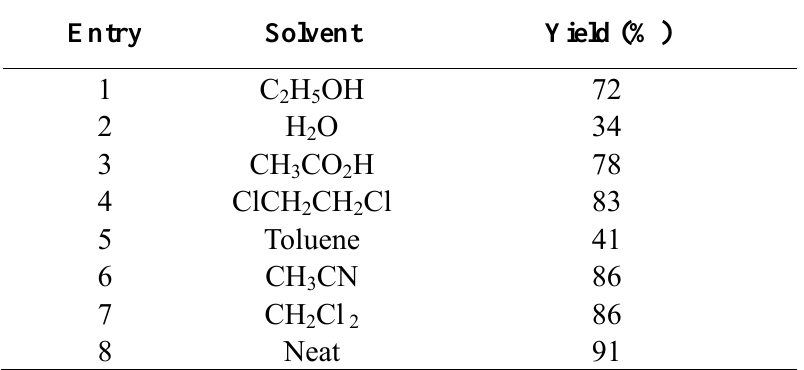
Table 2. Michael addition reaction of PTEA with aniline in protic and aprotic